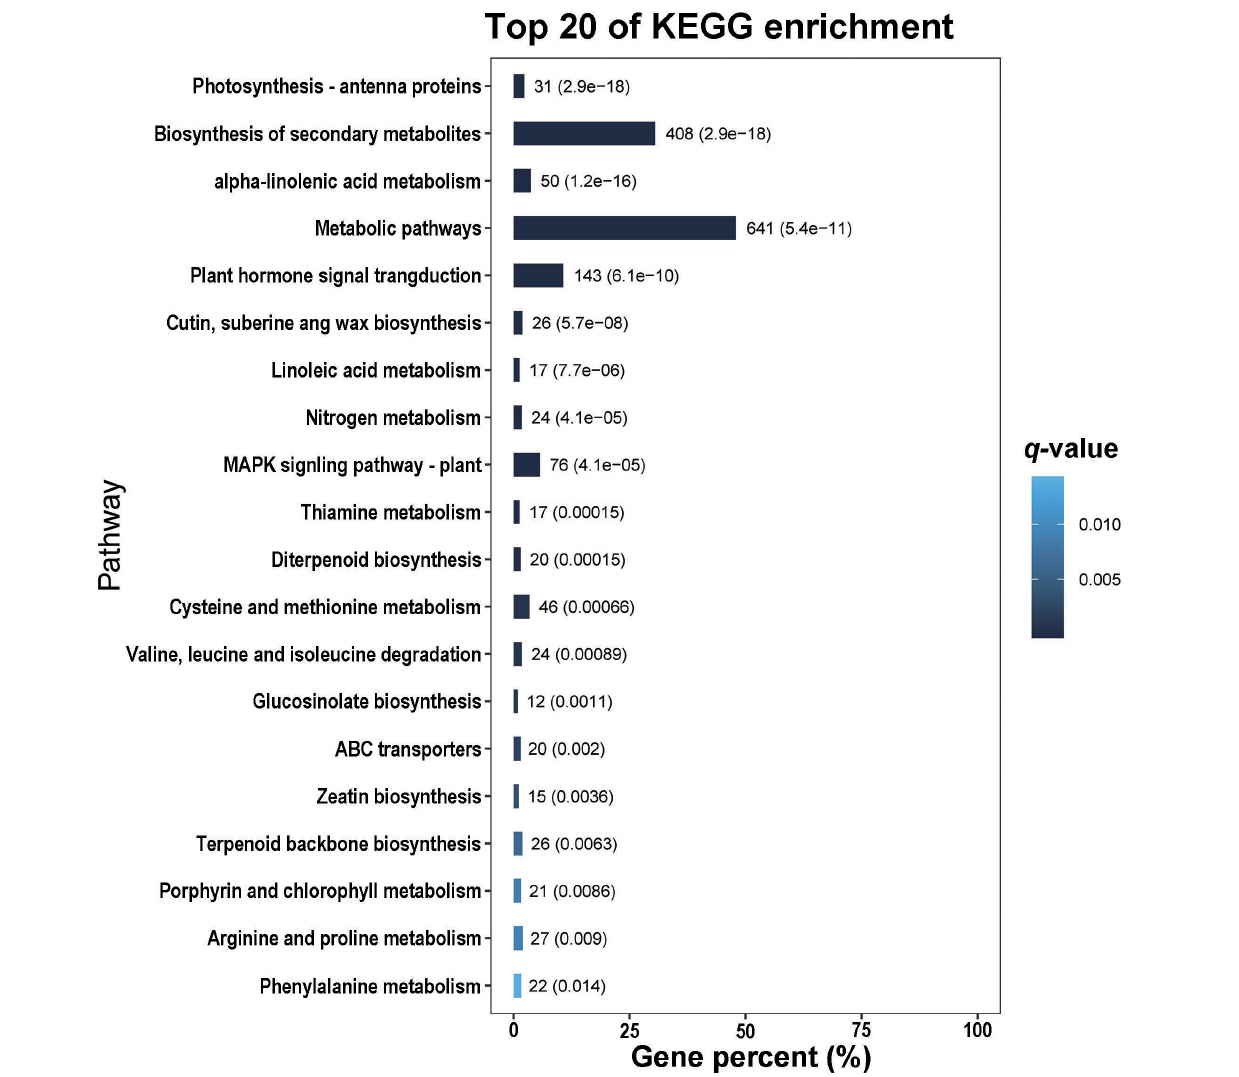
Frontiers in Plant Science |